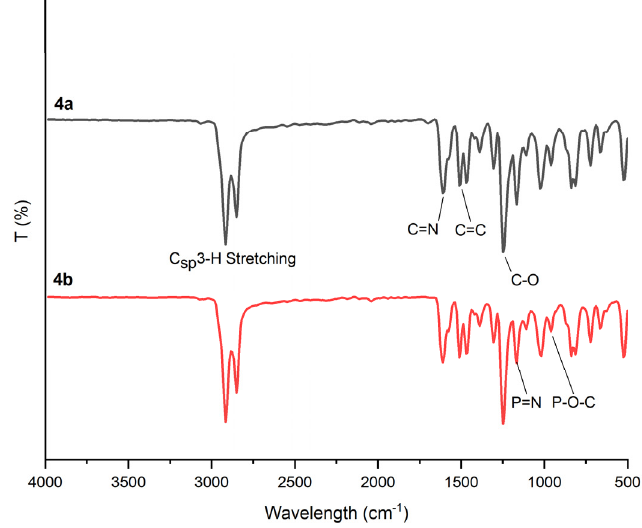
Figure 3. Overlay of FT-IR spectra of compounds 4a-b .